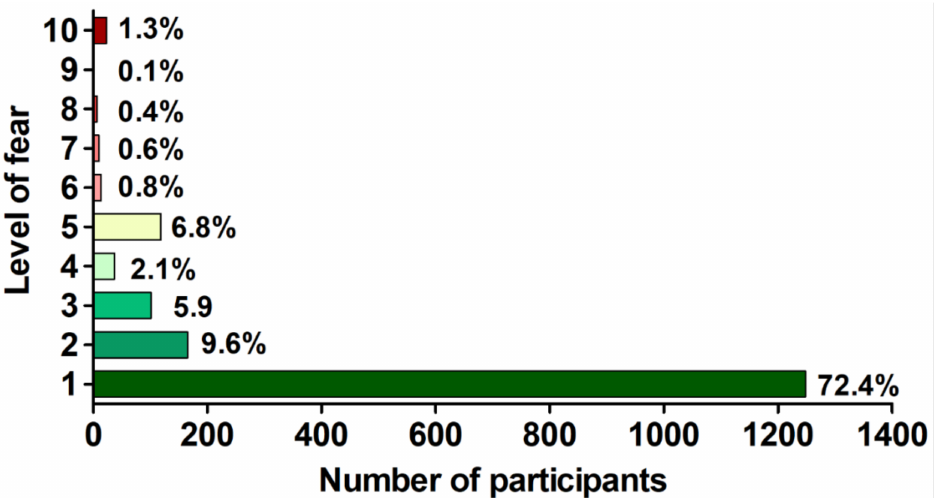
Figure 2. The distribution of level of fear (in 1–10 Likert-like scale) associated with a booster COVID- 19 vaccine dose in participants willing to receive it ( n = 1724).